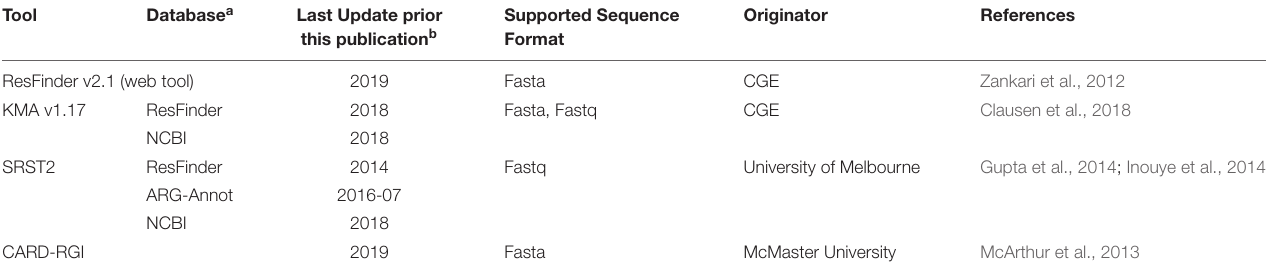
TABLE 1 | Characteristics of ARG detection